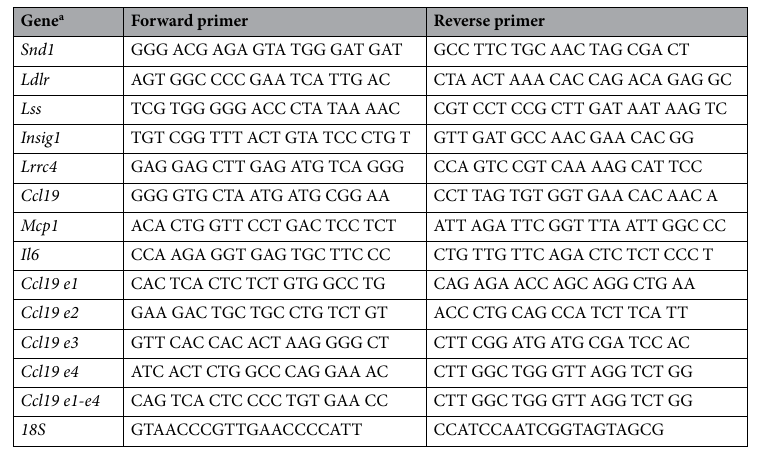
Table 4. Primers. a The sequences of primers used for realtime PCR are indicated. In addition, we designed primers to amplify the four exons of Ccl19 (e1, e2, e3, and e4). The primers used to identify Ccl19 isoforms ( CCl19 e1-e4) by PCR in adipose tissue are also